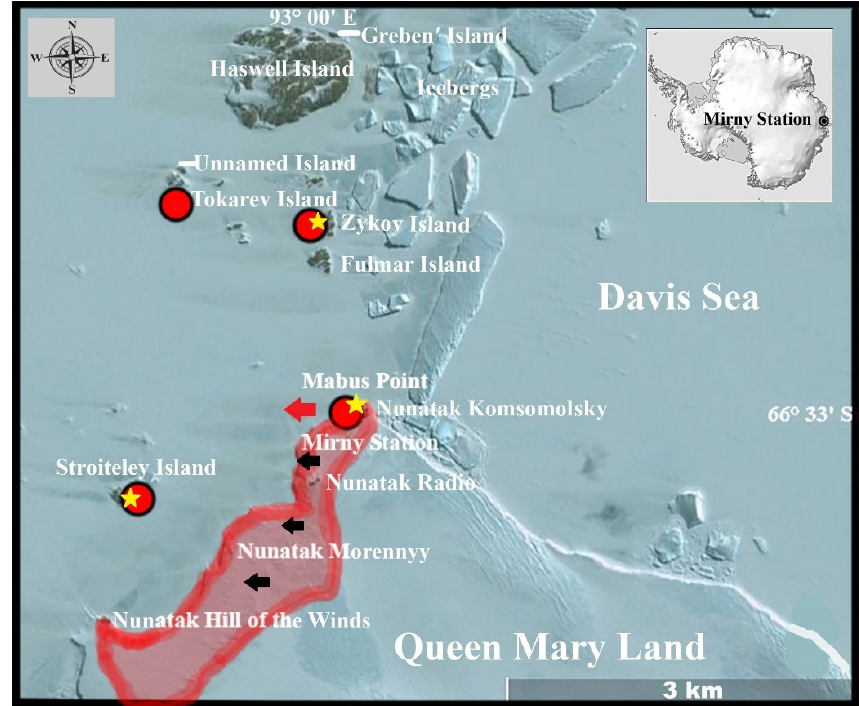
Figure 1. Distribution of pollution in the Haswell archipelago (in the inset in the upper right corner is the location of the Mirny Station). Satellite image Google Earth. Image © 2021 Maxar Technologies Image U.S. Geological Survey Image NASA. 28 October 2011. The names of the objects mentioned in the text are shown in white on the map. The territory of a garbage dump and old equipment containing oil pollutants is highlighted in pink. Red circles indicate hot spots where the greatest threats of oil contamination to birds, especially penguins, are present. Yellow asterisks indicate the sites of observations of the oiled Adélie Penguins. The red arrow shows the direction of movement of the oil film on the surface of the seawater from the source of contamination. The black arrows show the direction of movement of oil pollution on the surface of the continental ice during the summer period (explanations in the text).